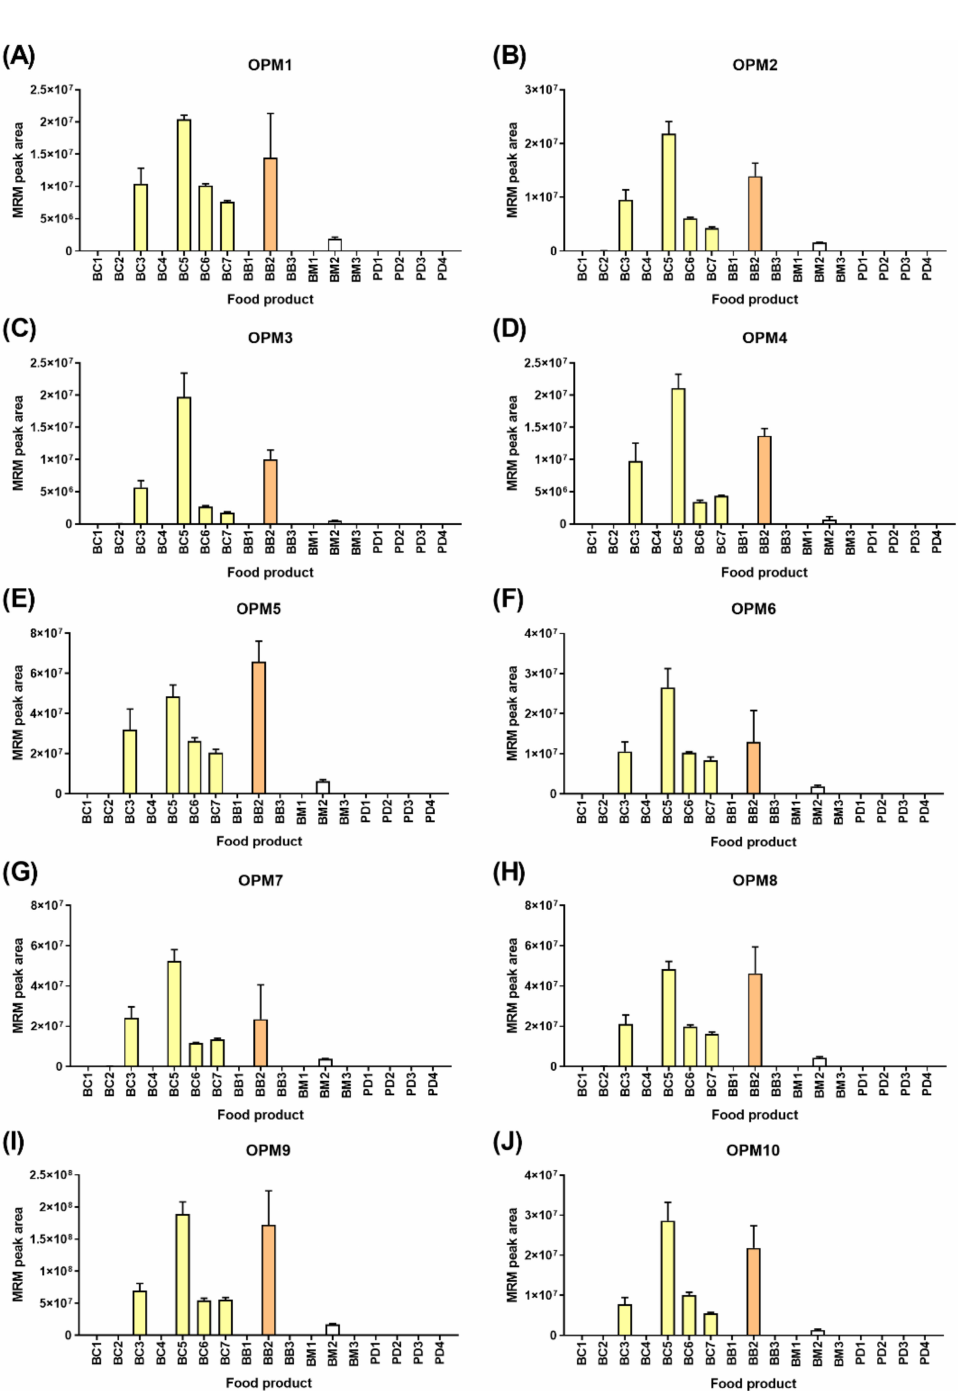
Figure 5. LC-MRM-MS analysis of 10 oat peptide markers (OPMs) across a range of commercial Australian breakfast food products. The peak area + SD is plotted ( n = 4). Panels ( A ) through ( J ) refer to the ten OPMs defined in Table